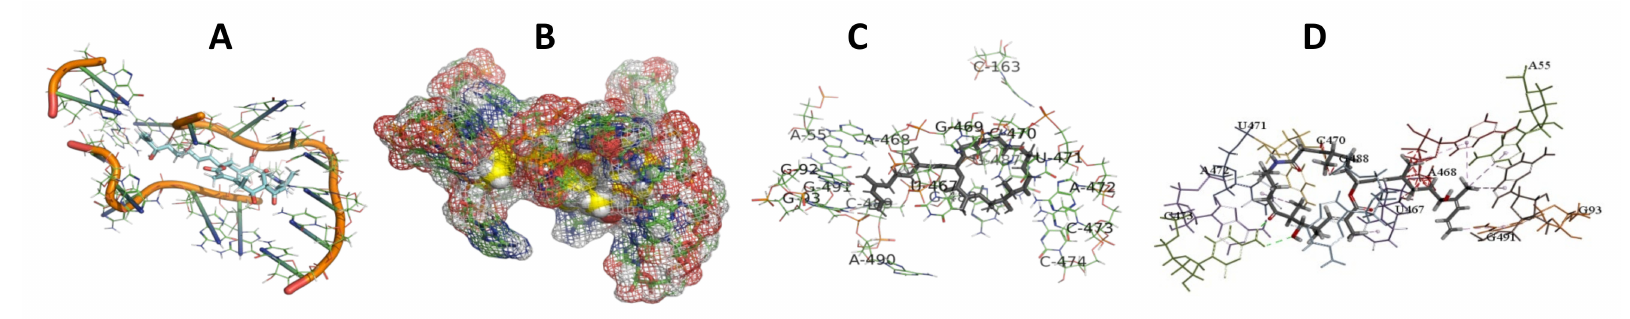
Figure 7. T. Brucei + Angiolam. ( A ): Best binding pose and nucleotides involved. ( B ): Schematic binding pocket. ( C ): shows the Nucleotides component that re involved in binding. ( D) : Shows the main bonds involved between the compound and the nucleotide